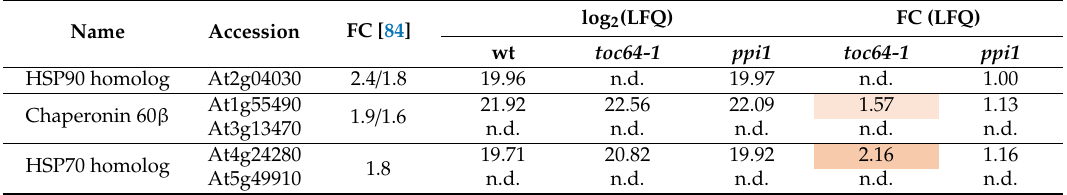
Figure 6. Proteomic alterations with respect to the genotype (top) or heat stress application (bottom). The results presented are summarized. On top, green indicates a higher and orange a lower abundance of the named protein in the indicated genotype (Fd: ferredoxin; CBC: Calvin Benson Cycle; for all other abbreviations and references see text). On the bottom, the color coding is according to the genotype (legend right bottom). Large letters indicate changes identified according to the described rule and small letters changes of at least two-fold. Normal letters indicated lower abundance (also indicated by downward arrow) and bold letters accumulation (upward arrow) when compared to the respective control sample. For further discussion, see text. Table 2. Comparison of protein changes in chloroplasts isolated from young (10 days; [84]) and older plants (21 days; present study). Given are the name, the accession number, the reported fold change for chloroplasts from 10-day old plants ( ppi1 / wild-type), the LFQ (log 2 ) observed here for the same proteins and the fold change of the LFQ for toc64-1 and ppi1 when compared to the wild type (wt). n.d.: not detected. Fold-change values > 1.5 are marked in